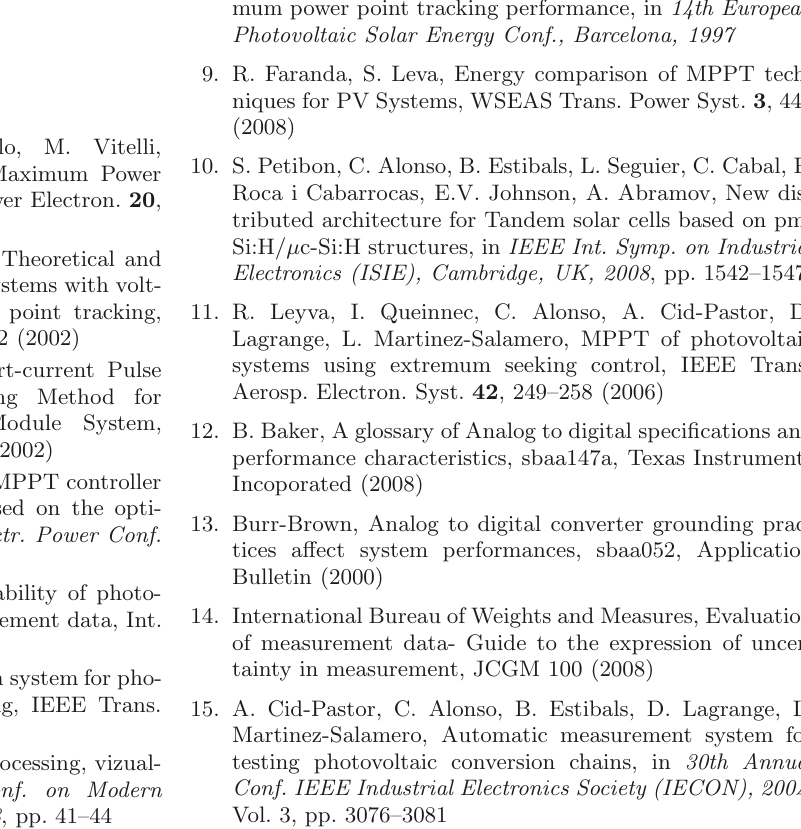
ATOS project. And, thanks to SOLEMS for their thin-film silicon photovoltaic